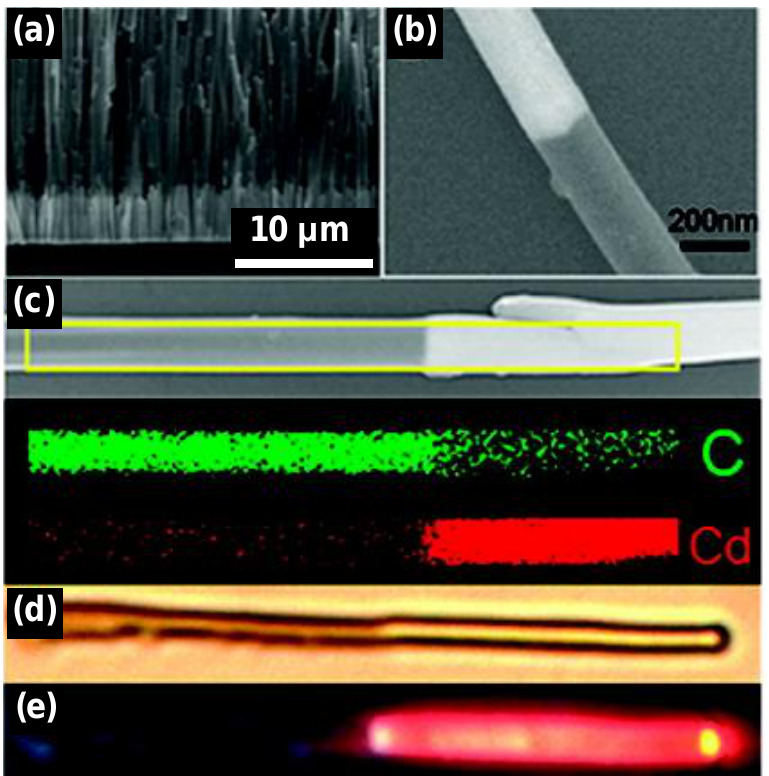
Figure 5. SEM images of CdS-PPy heterojunction nanowires: ( a ) side view image of CdS-PPy nanowires inside the alumina membrane template; ( b ) typical image of a single CdS-PPy nanowire; ( c ) element mapping of a single CdS-PPy nanowire; ( d ) optical image of a single CdS-PPy nanowire; ( e ) fluorescent image of a single CdS-PPy nanowire excited by a 405 nm laser. Adapted with permission from [33]; Copyright 2008, American Chemical